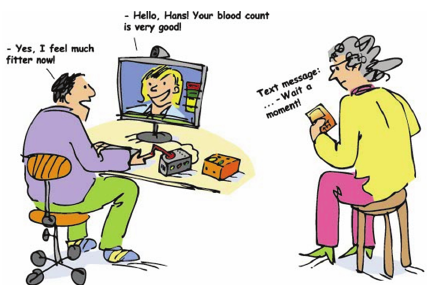
Figure 2: Web-based e-health services in the present.